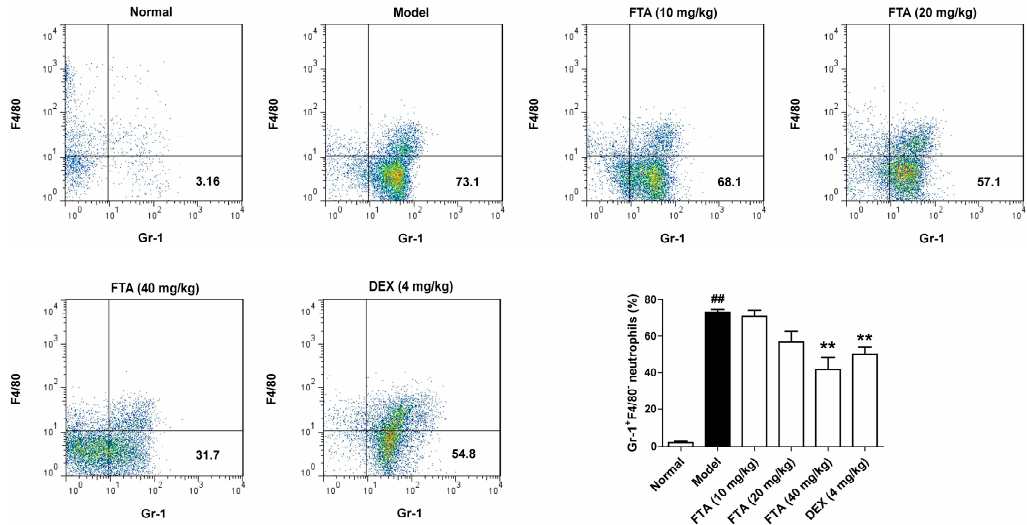
Figure 2. Influence of FTA on the inflammatory response in zymosan-induced peritonitis. Four hours after the injection of the zymosan, cells were extract from the peritoneal lavage fluid. The proportion of neutrophils (Gr-1 + F4/80 − ) was measured by flow cytometry. Data were expressed as means ± SEM ( n = 8). ** p < 0.01 vs. Model; ## p < 0.01 vs. Normal.